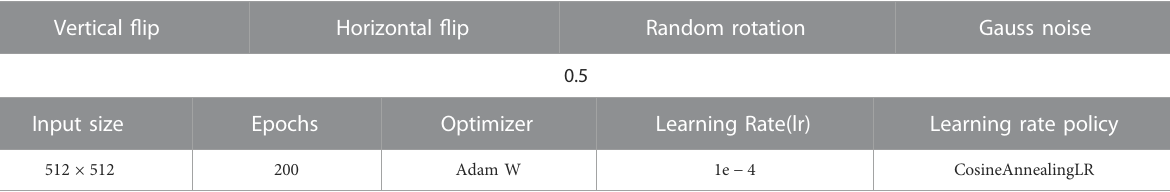
TABLE 1 Parameter setting during the training stage.